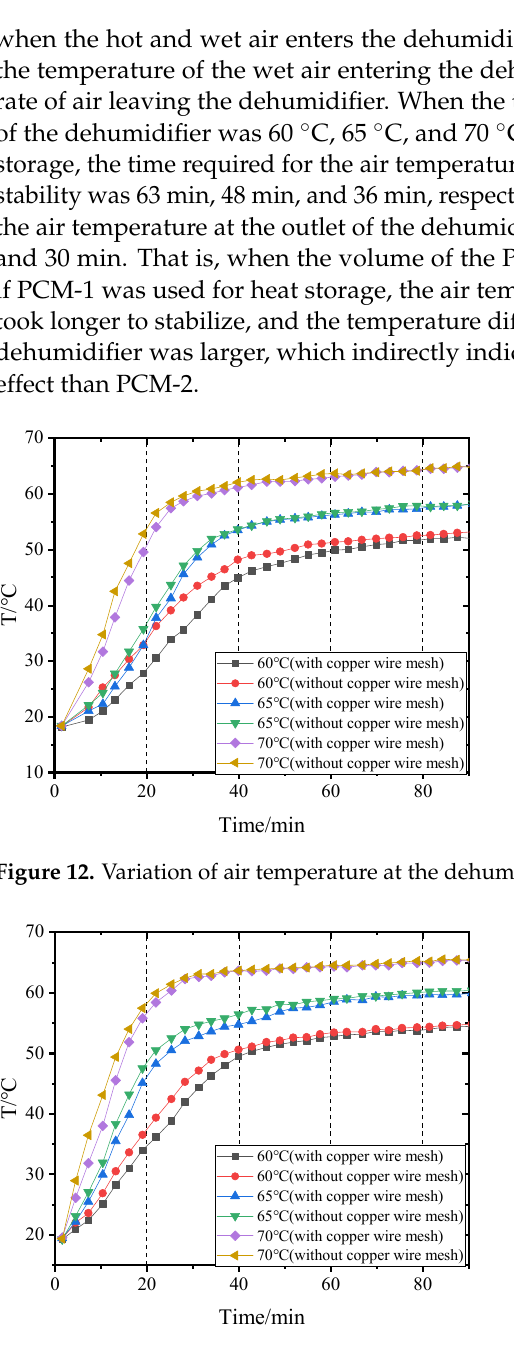
13 of 22 Figure 11. Experimental photos of temperature fields on PCM-2 upper surface. 4.3. Influence of Inlet Air Temperatures of Dehumidifier on Outlet Air Temperatures before and after Adding Copper Wire Meshes